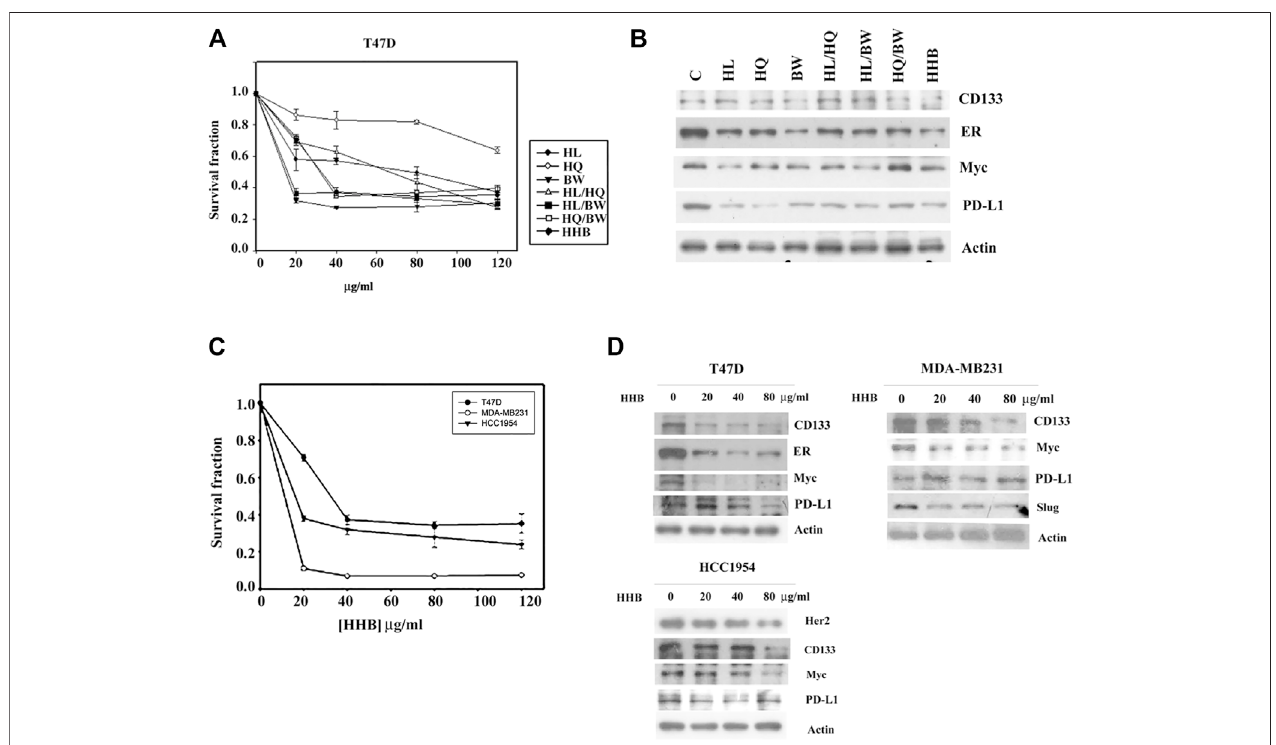
FIGURE5| ThebiologicaleffectoftheformulaHHB. (A) T47DcellsweretreatedwithvariousdosesofHL,HQandBWorallpossiblecombinationsfor4 days.The level of surviving cells was determined by MTT assay. Formula HHB is a combination treatment with HL, HQ and BW. (B) T47D cells were treated with 40 μ g/ml of each singleor allpossiblecombinations ofthe indicatedagentsfor24 h. Western blottinganalysiswasperformedtocharacterizethe changeinthe protein expression pro fi le. Three breast cancer cell lines, T47D, MDA-MB231 and HCC 1954, were treated with various doses of the formula HHB. The effect of the formula HHB on cell growthwasdeterminedbyMTTassay (C) ,andtheeffectonproteinexpression wascharacterizedbyWesternblottinganalysis (D) .Thesurvivalfractionshowedthefold change relative to the levels observed in the untreated control. The data are presented as the mean ± SD.